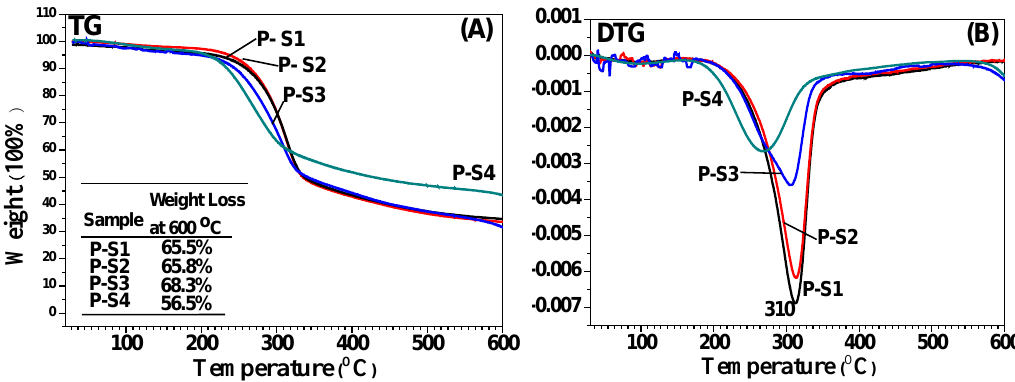
Figure 2. ( A ) Thermogravimetric (TG) curves and ( B ) differential thermal gravity (DTG) curves of bamboo charcoal-based composites precursors.